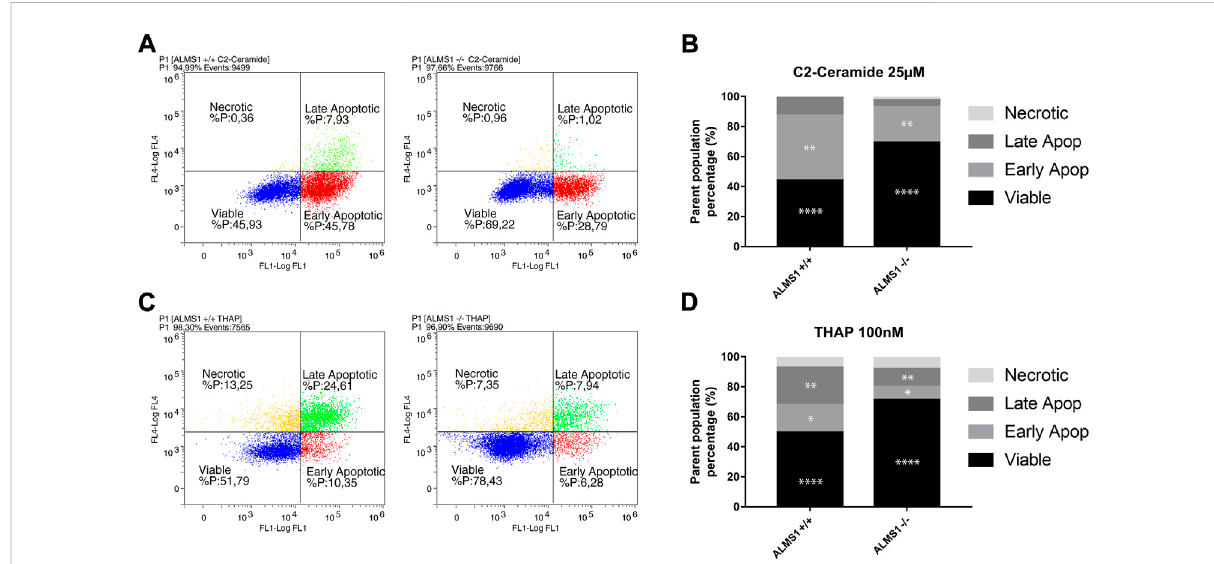
FIGURE 2 Apoptosis assay by annexin-V IP. (A) Cytometry plots for C2-ceramide (C2-C) with Log FL4 channel (IP) vs. Log FL1 channel (Annexin-v). (B) Stacked-bargraphforcellstreatedwithC2-Cinaconcentrationof25 µM.Percentagesofeachpopulationarerepresentedfromaparentpopulation previously de fi ned. (C) Cytometry plots for thapsigargin (THAP) with Log FL4 channel (IP) vs. Log FL1 channel (Annexin-v). (D) Stacked-bar graph for cells treated with THAP in a concentration of 100 nM. Percentages of each population are represented from a parent population